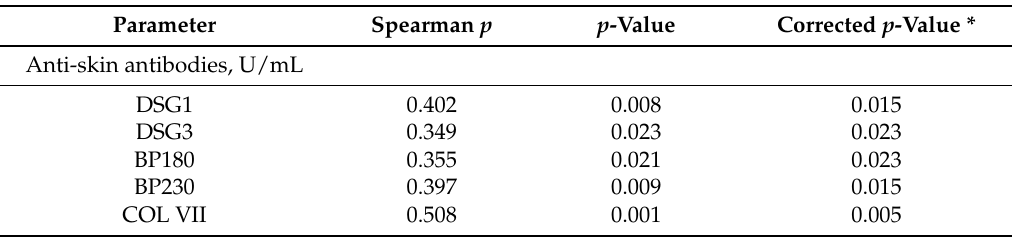
Table 6. Correlation between interleukin (IL)-6 serum level and anti-skin antibodies in inherited epidermolysis bullosa